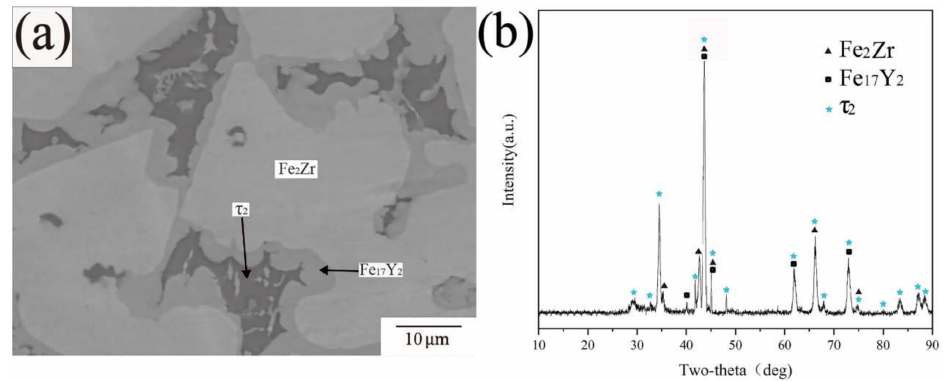
Figure 10. ( a ) BSE image of A4 ( b ) XRD pattern of A4.